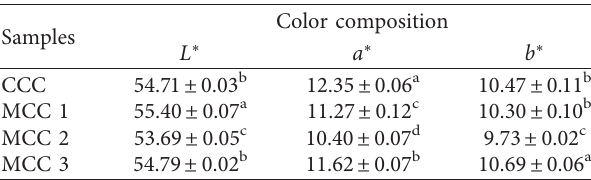
Table 8: Color composition of colored chicken meat obtained from a genuine supplier and three different